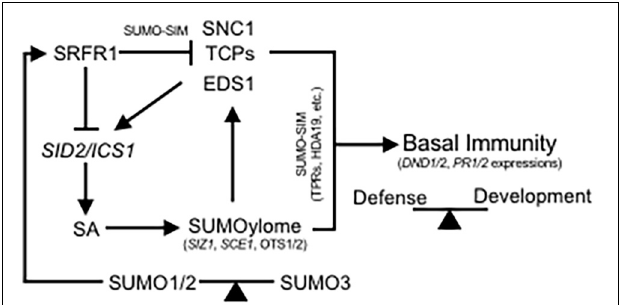
FIGURE 8 | Simplified schematic representation of crosstalk between SRFR1 and SUMOylome maintenance in defense-developmental balance. Under homeostasis, SRFR1 prevents SUMOylome perturbations via its suppression of SID2/ICS1 expression that drive SA responses. This mode of negative regulation incorporates transcriptional suppression of SUMO-conjugases (such as SIZ1 and SCE1 , among others), SUM3 , and protein stabilities of SUMO proteases OTS1/2. Basal SUMOylome adjustments in turn reciprocates on SRFR1 function at multiple levels. As SUMOylation and/or SUMO-binding candidates, intermolecular SUMO-SIM-type associations of SRFR1 with SNC1, TCPs, and EDS1 prevent mis-primed immune activations. Similar nature of association occurring between these immune players and their downstream targets (TPRs and HDA19) regulates expression of defense-responsive genes such as DND1/2 and PR1/2 , among others. SUMO1/2 or SUMO3 isoforms with their respective roles as negative or positive immune modulators balance the association stoichiometry through SRFR1 expression/stability. During a pathogen threat, transient reduction in SRFR1 initiates SUMOylome perturbations and activates defense players to execute defense signaling. A feedback signaling loop also initiated restoration of SRFR1 levels to avoid development penalties of constitutive